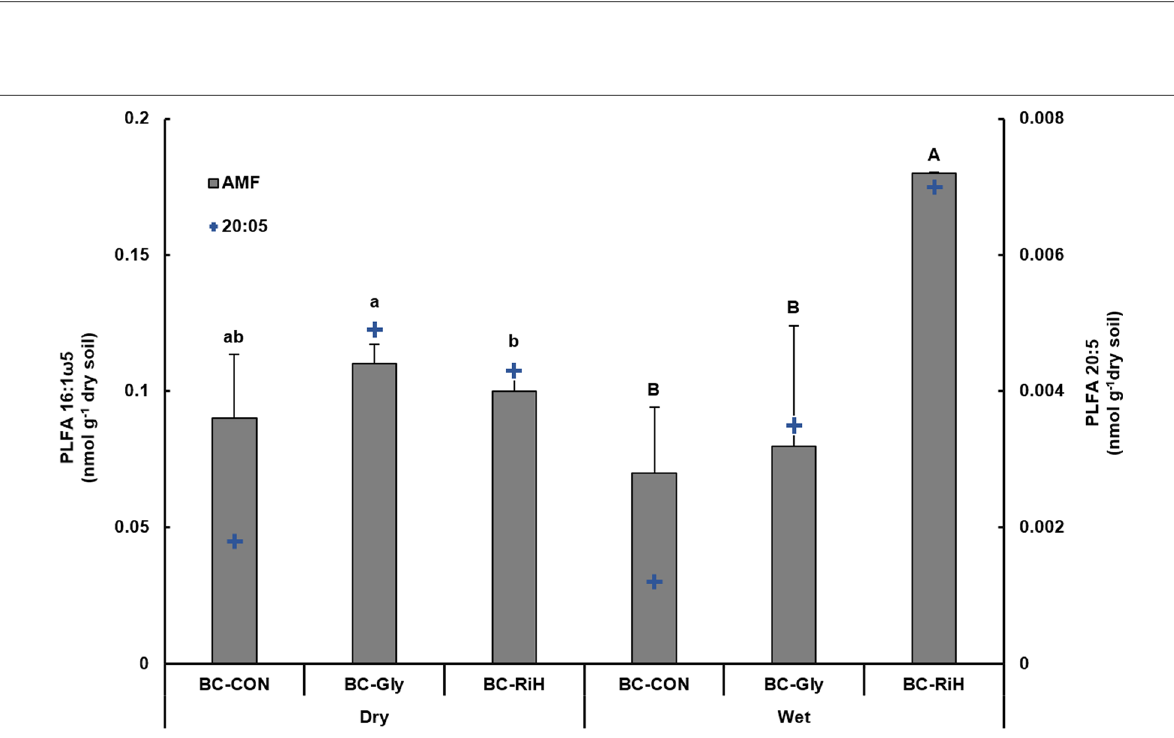
Fig. 4 The total 15 N transferred to the plants as a percentage of added fertilizer N. Different lowercase and capital letters indicate significantly different means (One-way ANOVA and LSD; p 0.05) between biochar treatments under dry and wet moisture conditions, respectively. Asterisks ≤ * indicate significantly higher values for the dry than for the wet moisture condition within a biochar treatment; Vertical bars represent standard errors of the means (n 3) =